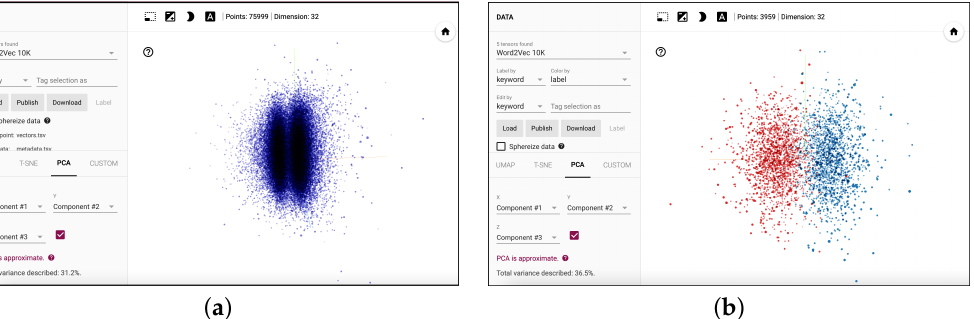
Figure 5. Word embedding as visualised in a 3-dimensional space. ( a ) Unlabelled word embedding space (75,999 points). ( b ) Labelled word embedding space (3959